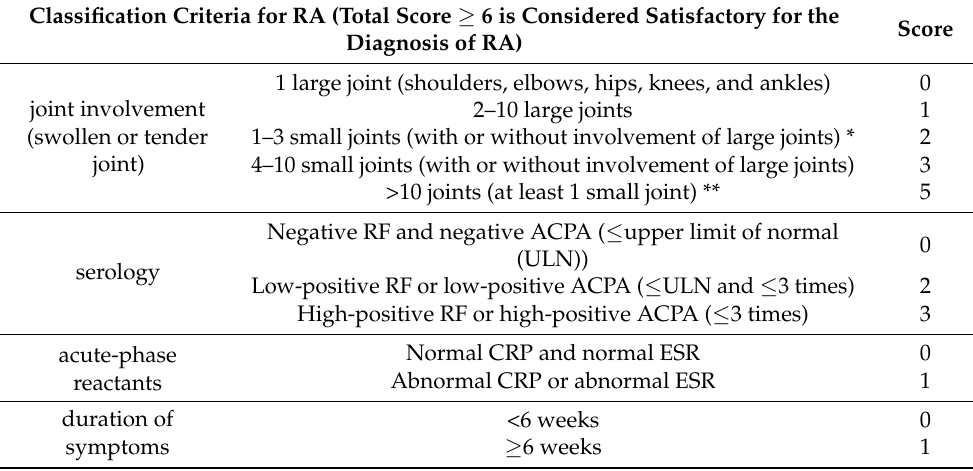
Table 1. The 2010 ACR/EULAR classification criteria for RA. Classification Criteria for RA (Total Score ≥ 6 is Considered Satisfactory for the Diagnosis of RA)